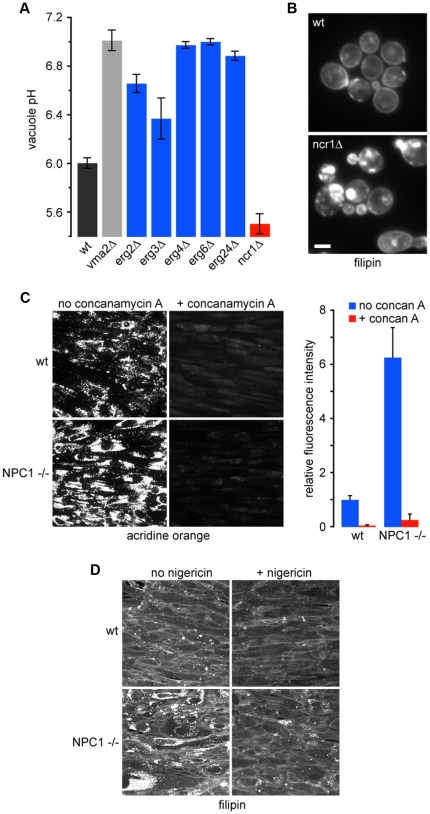
Lysosomal hyperacidification accompanies a cellular Niemann-Pick type C phenotype.(a) Vacuoles in ergosterol accumulating ncr1Δ cells are hyperacidic, whereas erg mutants lacking ergosterol have abnormally alkaline vacuoles. (b) Intracellular sterol accumulates in ncr1Δ yeast. Yeast cells were stained with filipin to detect sterol in the presence or absence of NCR1. Bar, 2 µm. (c) Fibroblasts harboring pathogenic alleles of NPC1 (P237S/I1061T) have hyperacidified lysosomes. Wild type cells from a control subject (wt) or mutant cells from a patient with Niemann-Pick type C disease (NPC1−/−) were stained with acridine orange in the absence or presence of 10 nM concanamycin A1 (concan A), an inhibitor of the V-ATPase. Bar, 10 µm. Cellular acridine orange fluorescence was quantified relative to untreated wild type cells; bars represent standard deviations (n = 100 cells). (d) Nigericin prevents aberrant accumulation of cholesterol in lysosomes of NPC1−/− mutant cells. Cells were stained with filipin to detect cholesterol in the presence or absence of 10 nM nigericin, a K+/H+ ionophore.